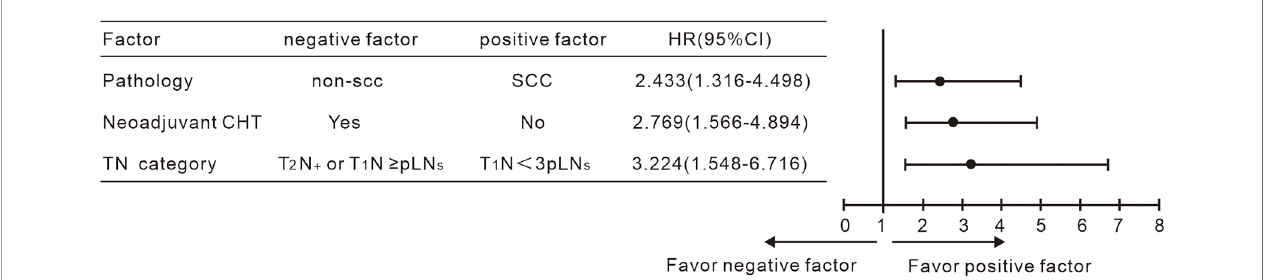
FIGURE 3 | Multivariate Cox analysis including the TN category shown non-SCC, neoadjuvant chemotherapy and T 2 N +/ T 1 N < 3 pLN to be negative indicators